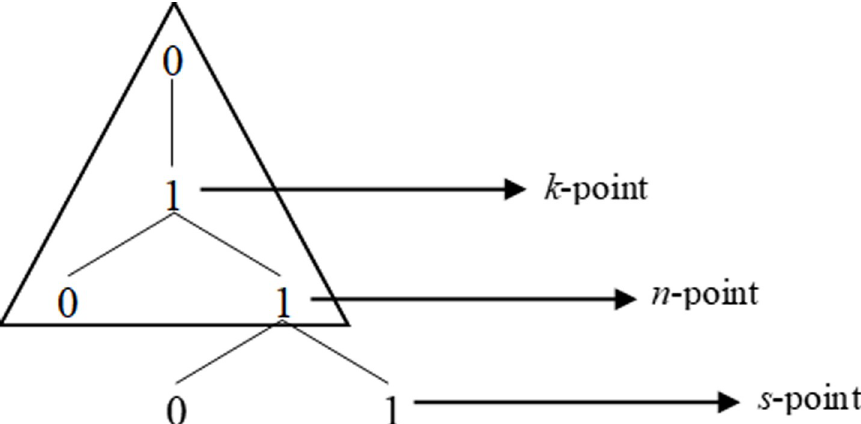
Fig 7. Representation of the configuration of k -, n - and s -points in